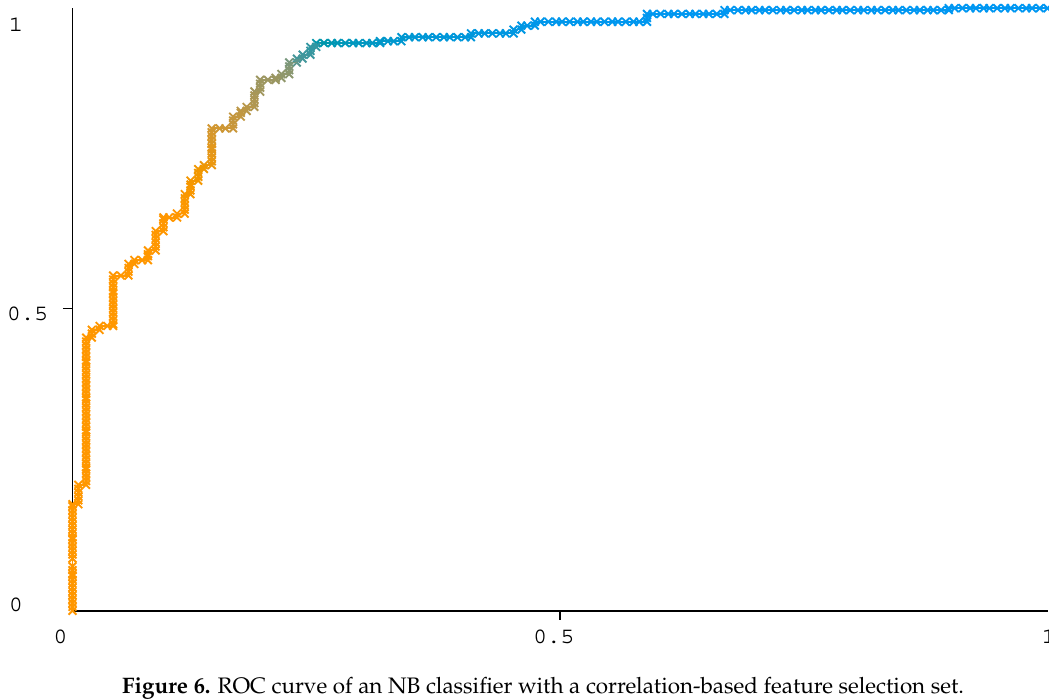
As shown in Table 9, the maximum accuracy of 86.468% was attained with the sequen-